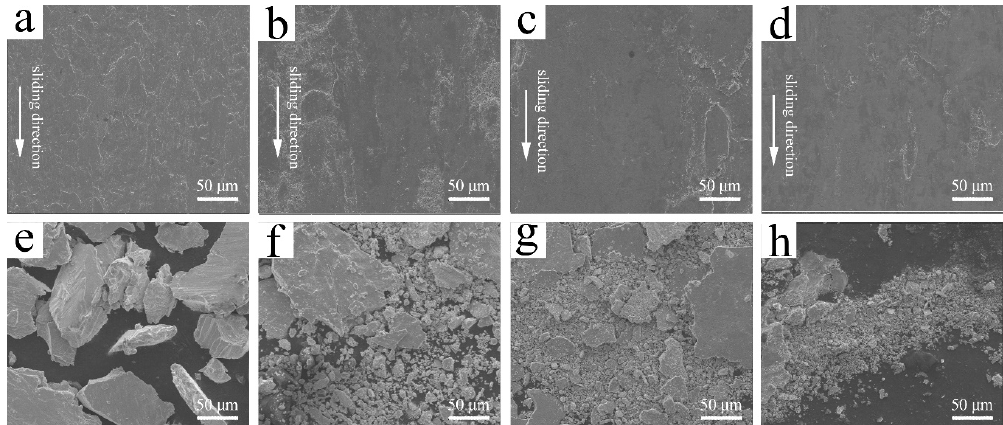
Figure 10. SEM images of the worn surface of ( a ) HEA, ( b ) HEA-10TiC, ( c ) HEA-20TiC, and ( d ) HEA-30TiC composites and corresponding debris of ( e ) HEA, ( f ) HEA-10TiC, ( g ) HEA-20TiC, and ( h ) HEA-30TiC composites after wear at high temperature.